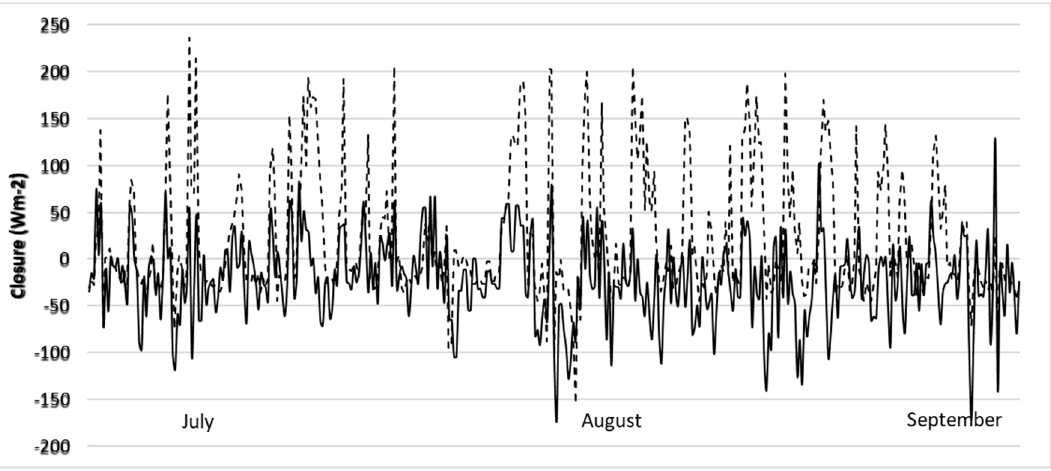
Figure 2. (R n − G − H EC − LE Lys ), solid line, and (R n − G − H EC − LE EC ), dashed line, values for samples with IFTT ≥ 85%. The x- axis shows chronological order.